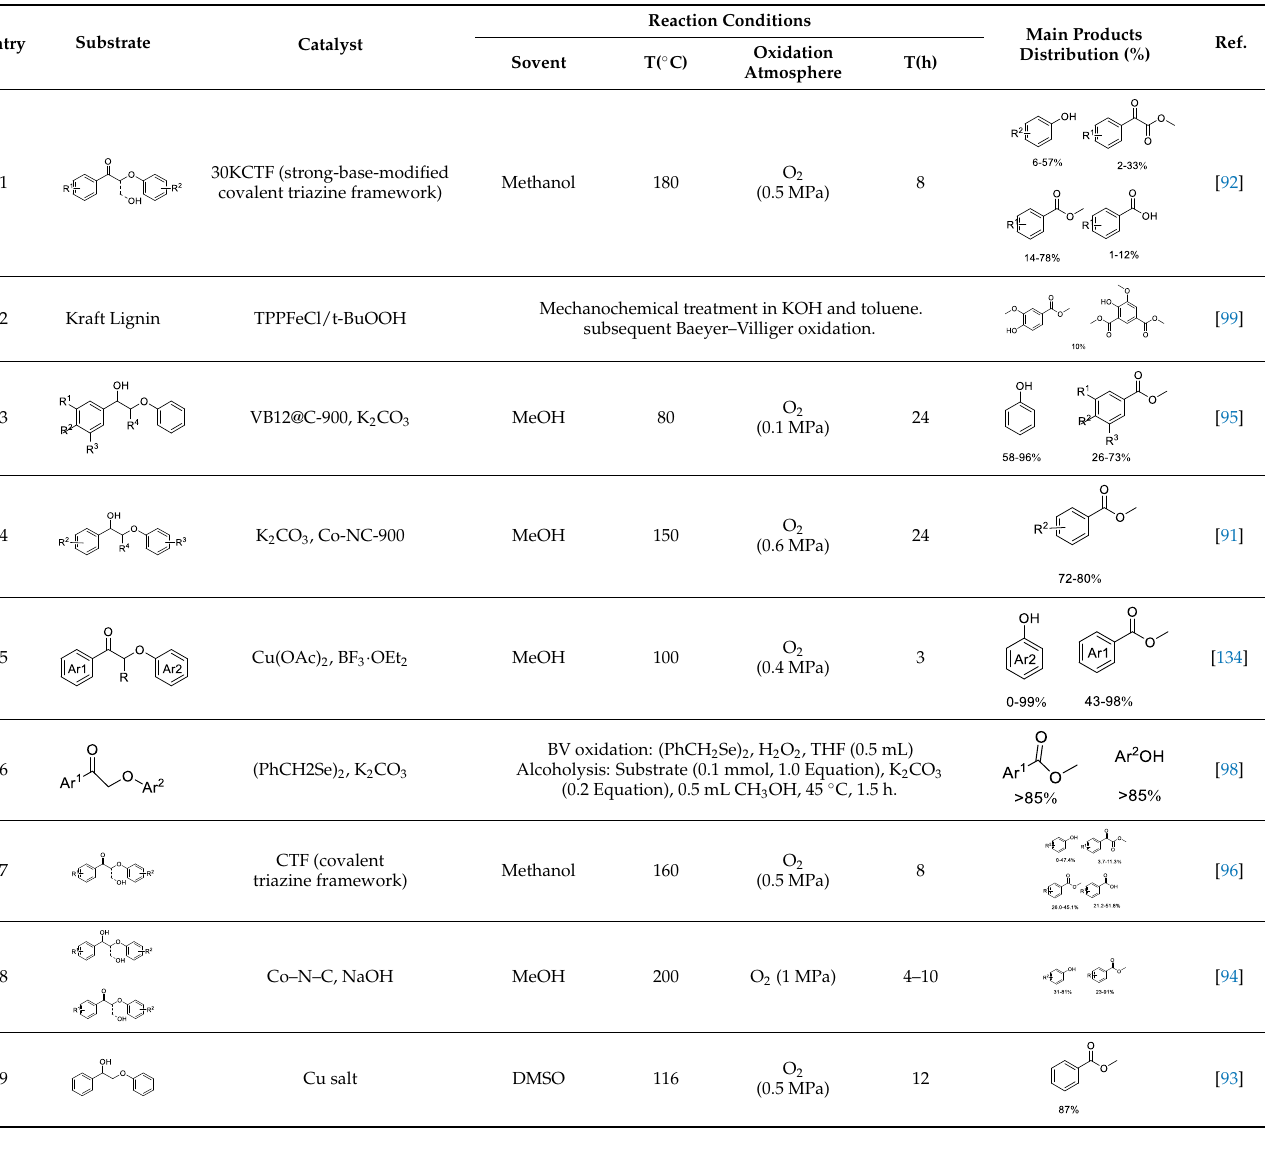
Table 1. Transformation of lignin or its model compounds to aromatic esters.